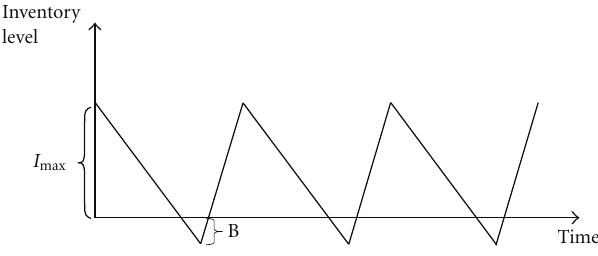
Figure 1: The representation of the EPQ model with backorders.